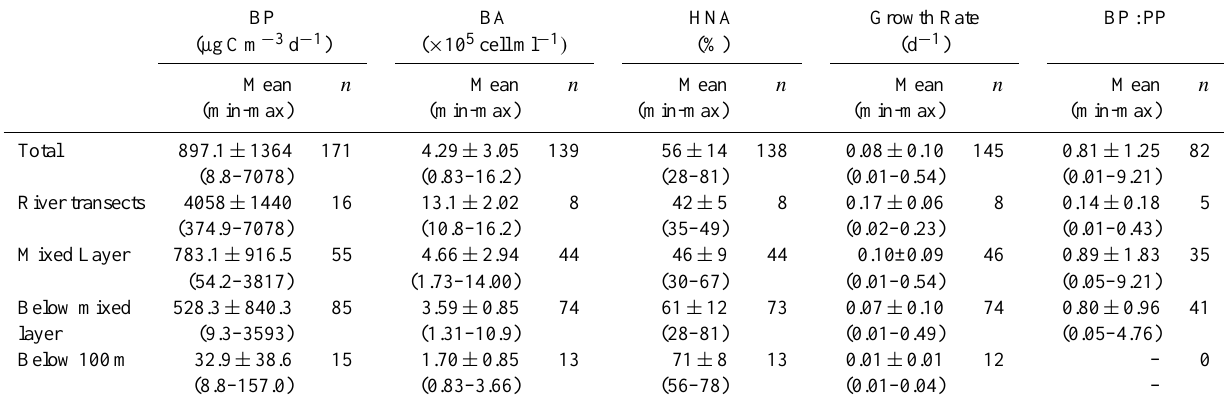
Table 1. Averages ( ± standard deviation) and ranges of bacterial production (BP), abundance (BA), percentage of high nucleic acid bacteria (HNA), growth rates and bacterial production to primary production ratios (BP:PP) considering all data, Mackenzie River waters, marine waters within the upper mixed layer, marine waters from below the upper mixed layer to 100m, and deep waters below 100m. BP BA HNA Growth Rate BP:PP (µgCm − 3 d − 1 ) ( × 10 5 cellml − 1